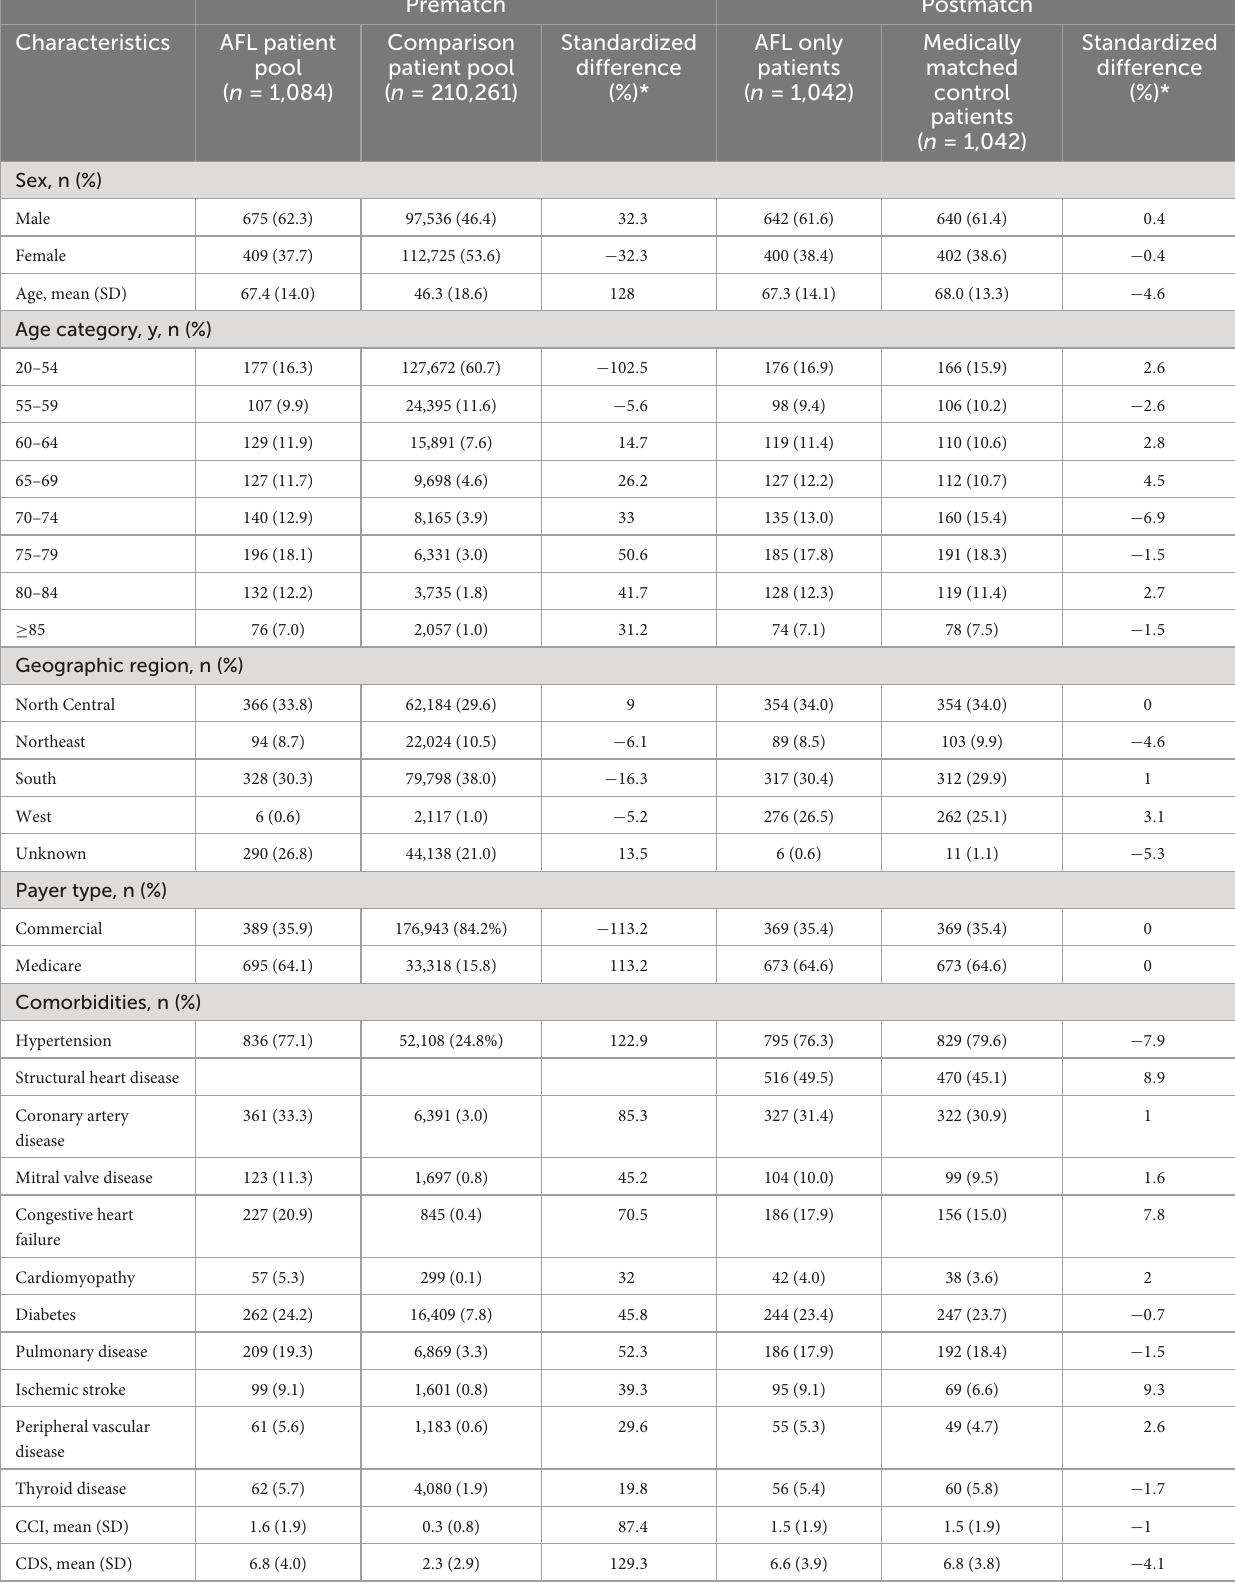
TABLE 1 Patient demographics and comorbidities (before and after